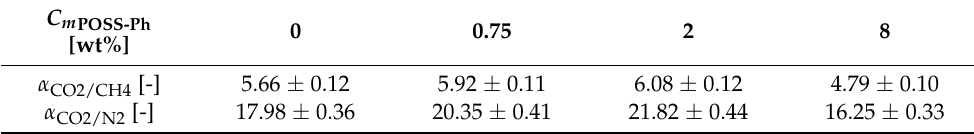
Table 9. Coefficients of ideal selectivity α i/j for membranes of different POSS-Ph